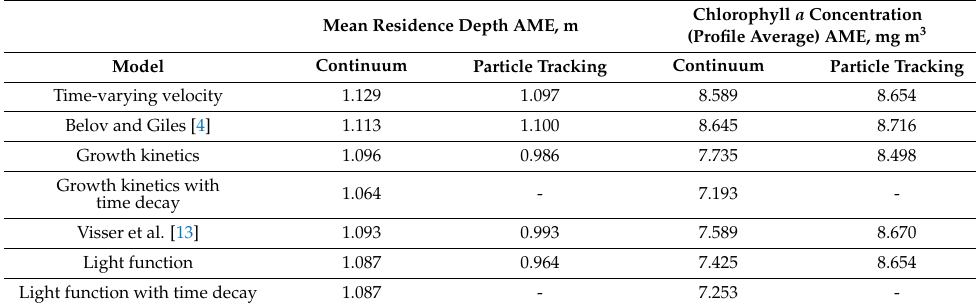
Table 5. Error statistics for models of the Shennong Stream open water